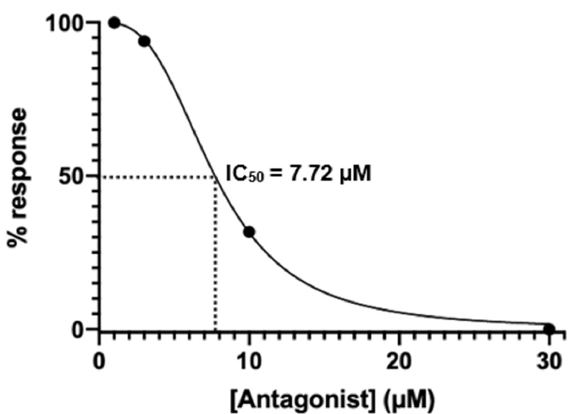
Figure A3. IC 50 of NS8593 assessed by NKCCA. The IC 50 of NS8593 was determined using flow cytometric cell lysis assays where NK cells isolated from HCs were treated with NS8593 (0, 3, 10, 30 µM), IL-2 (20 IU/mL), and NTB (25µM) for 24 h to inhibit TRPM7 before incubating with K562 for cell lysis to occur ( n = 4). Statistical analysis determined the IC 50 of NS8593 under these conditions